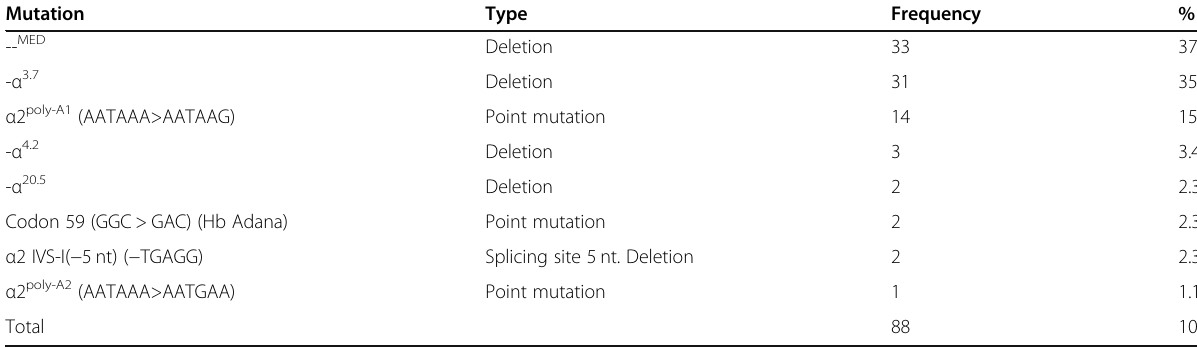
Table 2 Mutation frequency in HbH disease patients